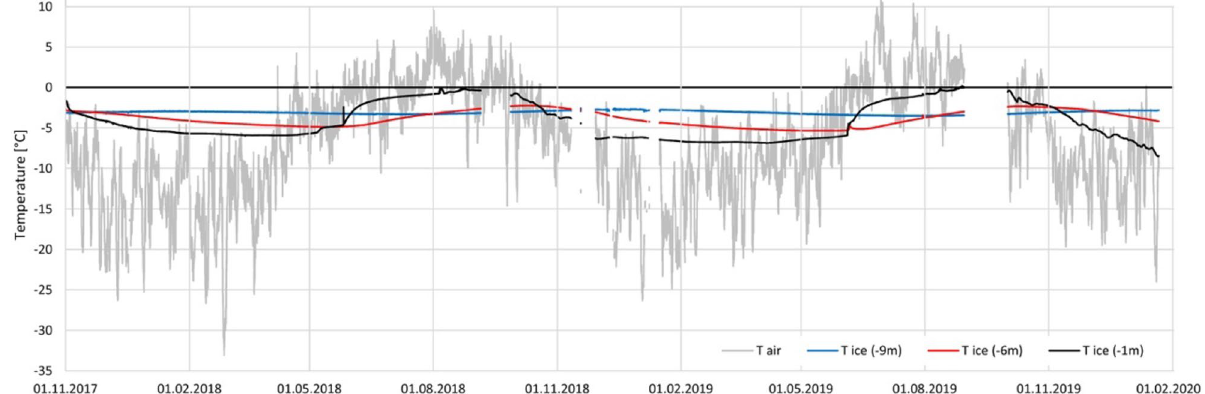
Figure 5. Results from englacial temperatures from the automatic weather station at the WSS summit (grey: air temperature, blue: ice temperature at 9 m depth, red: ice temperature at 6 m depth, black: ice temperature at 1 m depth). Sub-zero temperatures at 9 m depth with a mean temperature of − 3.1 °C for the whole period indicate that the basal ice below is frozen to bedrock, despite air temperatures of up to 11.1 °C inducing strong surface melt. Figure made with licensed software Microsoft Excel 2016 (https ://www.micro soft.com/).